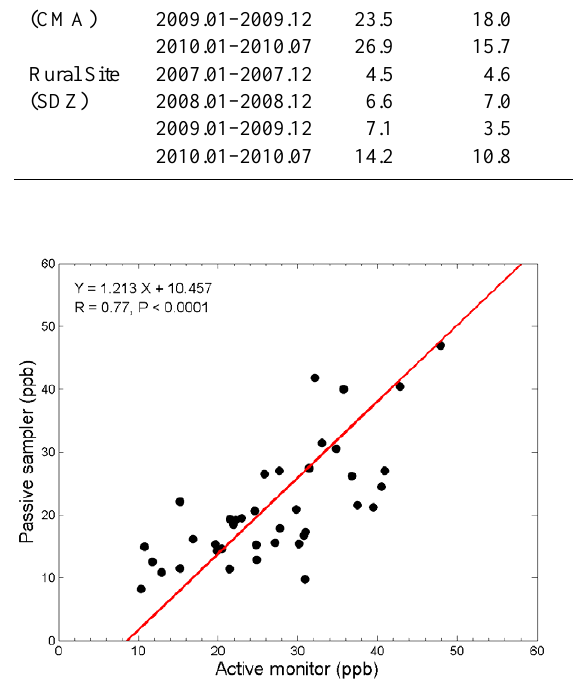
Fig. 2. Comparison of results obtained with the Ogawa passive sampler and an active monitor at CMA from June 2009 to May 2010. The reduced major axis regression is performed for the statistics. from 0.8 to 42.9 ppb, with the annual average concentrations of 4.5 ± 4.6, 6.6 ± 7.0 and 7.1 ± 3.5 ppb in 2007, 2008 and 2009,